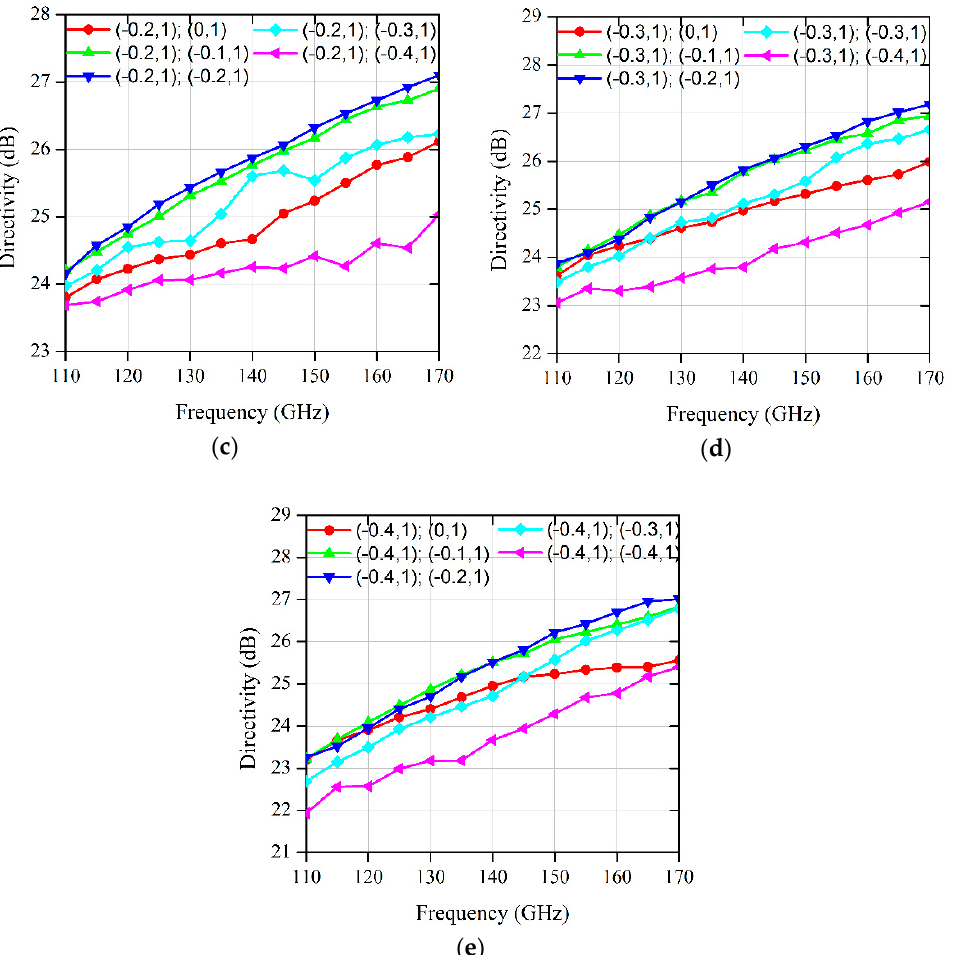
Figure 5. Directivity index (dB) by varying the position of principal unit normal vector points ( x 1 , y 1 ) and ( x 2 , y 2 ) as ( a ) (0, 1) and ({ x 2 }, 1); ( b ) ( − 0.1, 1) and ({ x 2 }, 1); ( c ) ( − 0.2, 1) and ({ x 2 }, 1); ( d ) ( − 0.3, 1) and ({ x 2 }, 1); ( e ) ( − 0.4, 1) and ({ x 2 }, 1).